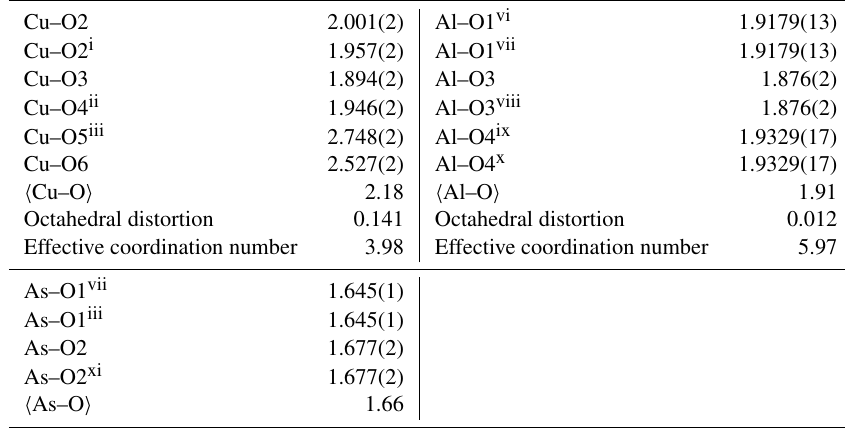
Table 4. Selected interatomic distances (Å) and polyhedral-distortion measures in the structure of liroconite.